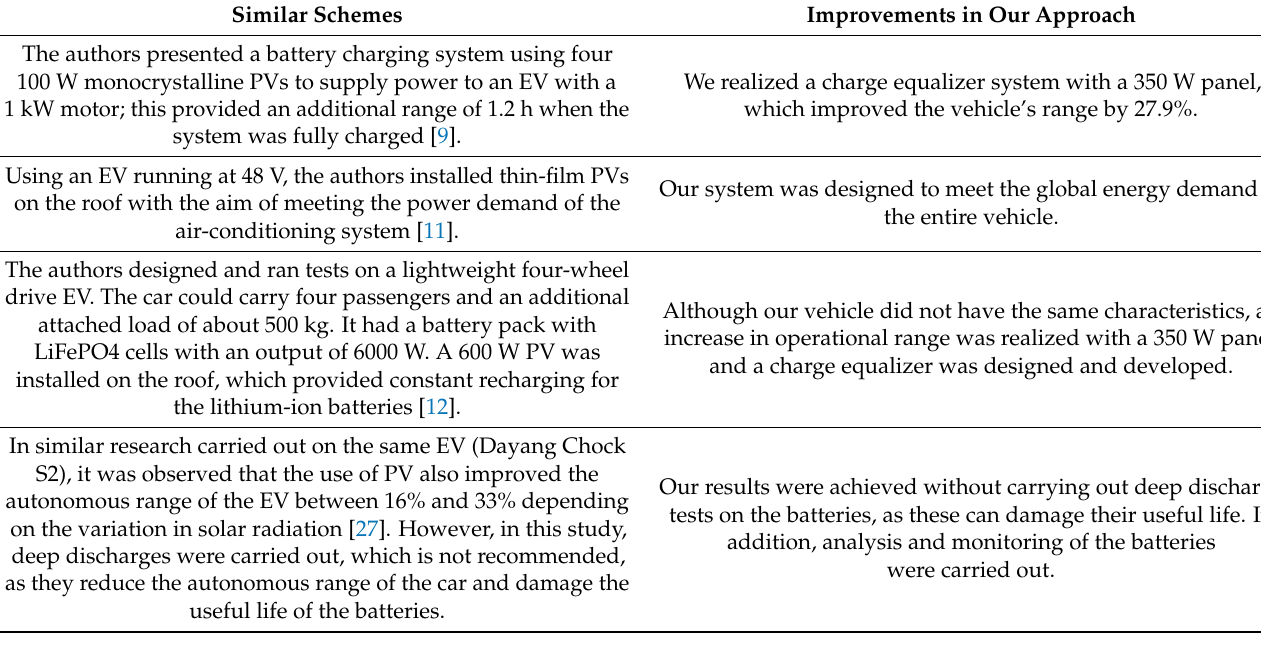
Table 5. Improvements obtained by our approach compared to similar